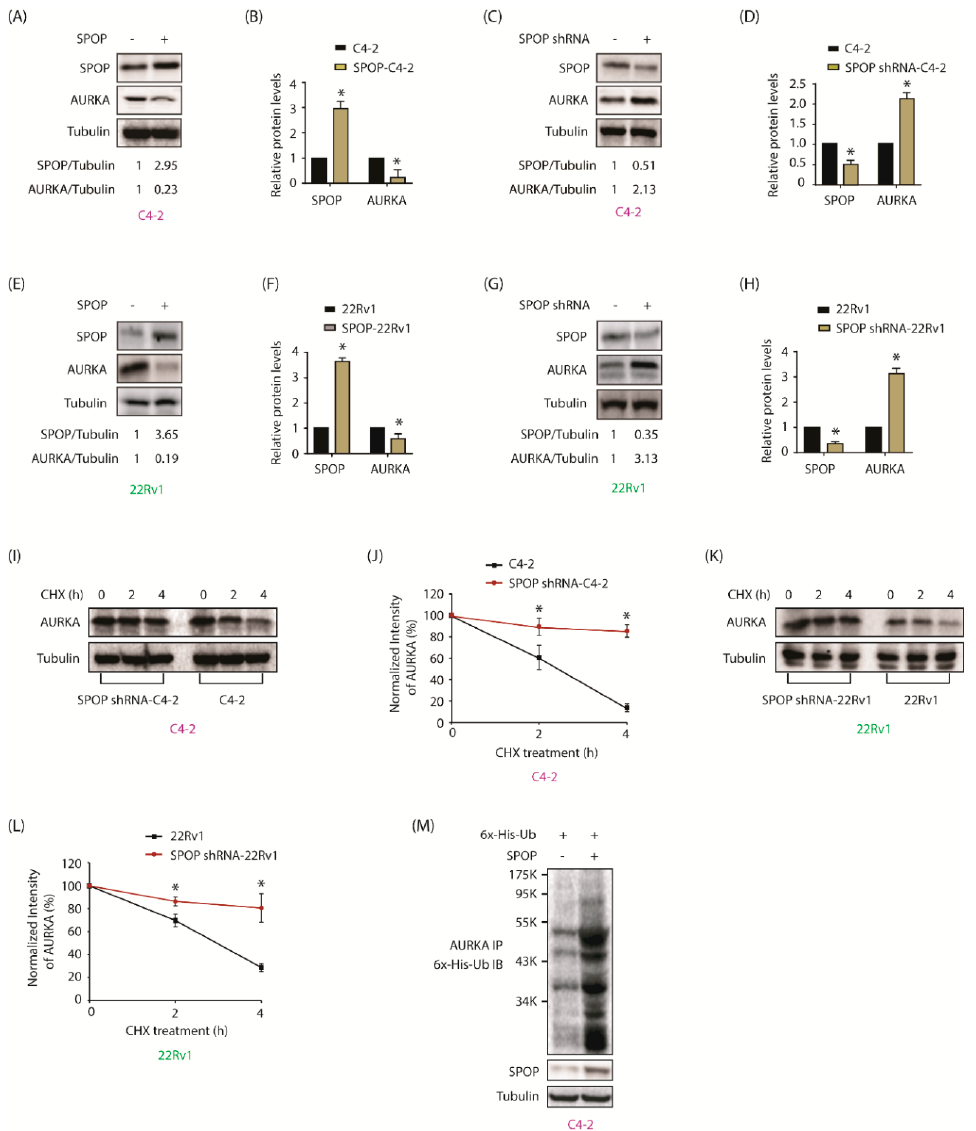
Figure 3. AURKA is targeted by SPOP in a reciprocal crosstalk. ( A ) SPOP inversely regulates AURKA protein levels in C4-2 cells. ( B ) Histogram shows decrease in AURKA level with SPOP overexpression. The data presented as mean ± SEM obtained from three independent experiments. * p < 0.05 vs. C4-2 control cells. ( C ) SPOP knockdown increases AURKA in C4-2 cells. ( D ) Histogram shows increase in AURKA levels with SPOP knockdown. The data are presented as mean ± SEM obtained from three independent experiments. * p < 0.05 vs. C4-2 control cells. ( E ) and ( F ) 22Rv1 cells showing change in AURKA protein levels with SPOP overexpression. ( G ) and ( H ) 22Rv1 cells showing change in AURKA protein levels after SPOP silencing. ( I ) SPOP decreases the half-life of AURKA. C4-2, and SPOP-shRNA-C4-2 were treated with 10 µ M cycloheximide and protein lysates were collected at the indicated times for western blot analysis. ( J ) AURKA protein levels was quantified and plotted relative to the level at t = 0. ( K ) SPOP augments AURKA degradation in 22Rv1 cells. ( L ) Graphical representation of AURKA degradation rate in cells treated as in Figure 3K. ( M ) SPOP increases AURKA degradation by promoting its ubiquitylation. C4-2 cells were co-infected with 6x-His-ubiquitin (6x-His-Ub) along with SPOP retrovirus for 30 h, followed by MG132 treatment for 12 h. AURKA was immunoprecipitated and ubiquitylation analyzed using 6x-His antibody. Each experiment was done at least three independent times. Representative data are